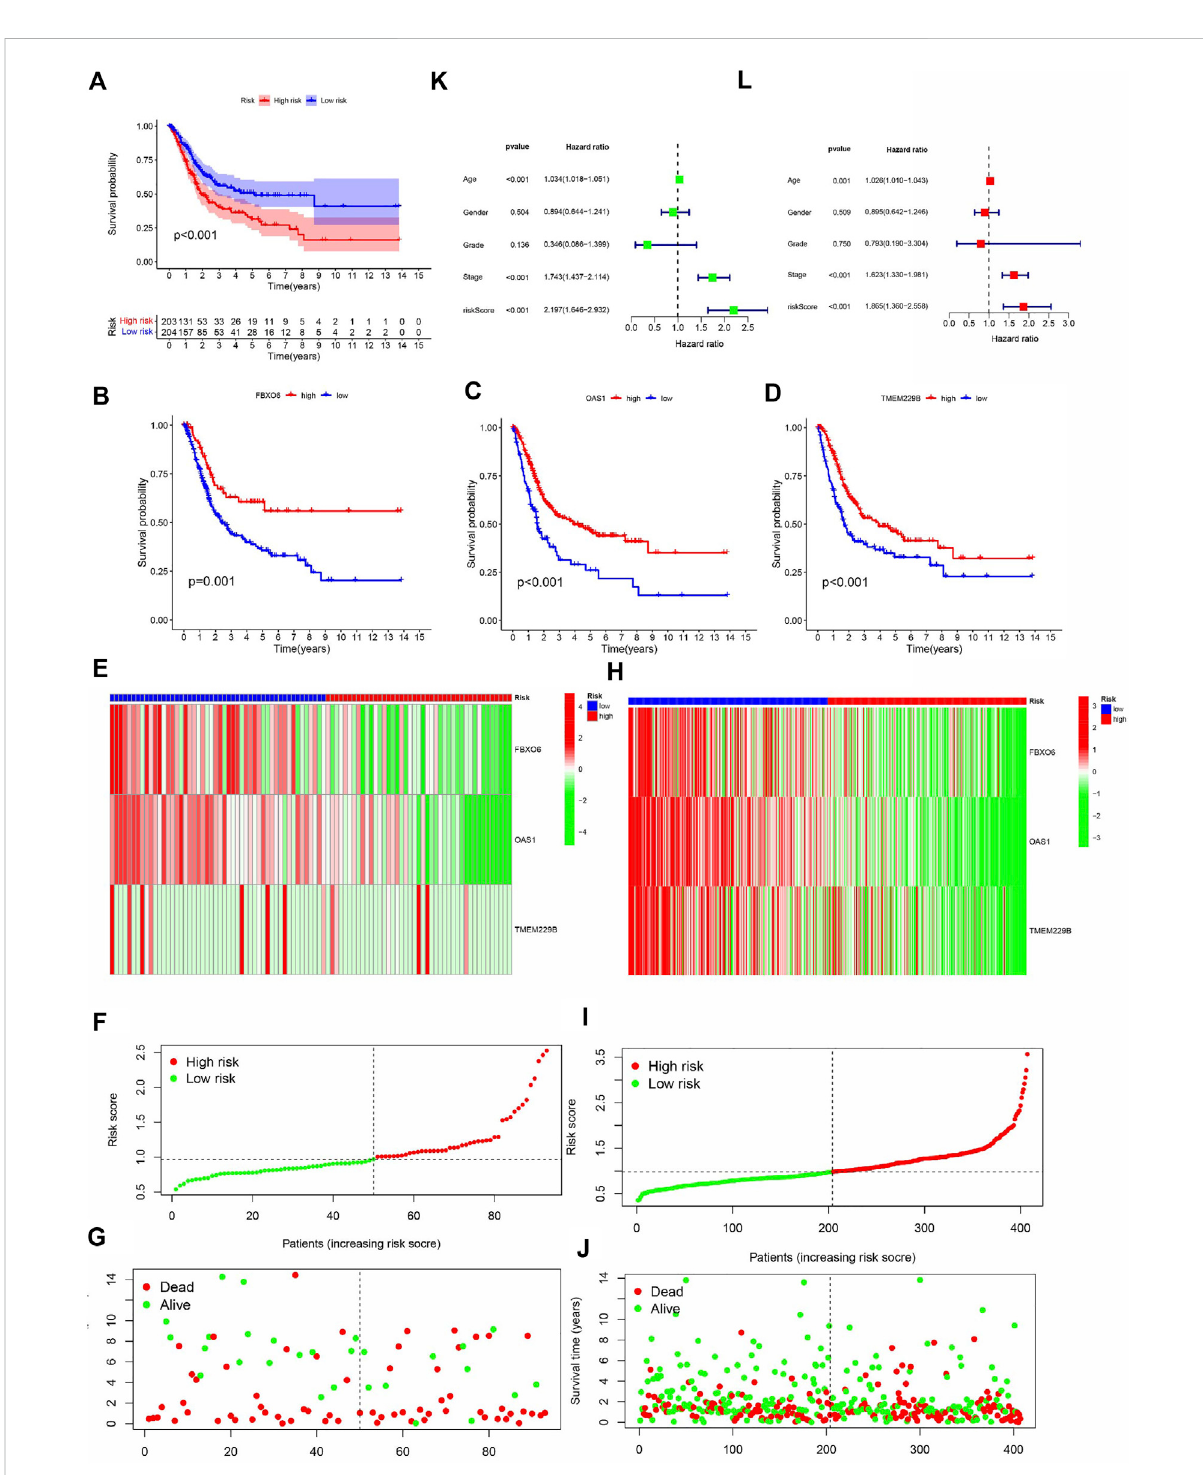
FIGURE 4 (A) TheanalysisofKaplan-Meiercurveshowsthatthereisadifferenceintheoverallsurvivalratebetweenhigh-riskandlow-riskgroups.Kaplan- MeiercurveanalysisshowedthatthereweredifferencesintheoverallsurvivalratesofFBXO6 (B) ,OAS1 (C) ,andtem229b (D) inhigh/low-riskgroups. IntheGEO (E) andTCGA (H) cohorts,heatmapsofFBXO6,OAS1,andTME229generatiosweredrawnforeachBLCAsample.IntheGEOcohort (F) as well as in the TCGA cohort (I) , the distribution of multi-genes model risk score. In the GEO cohort (G) as well as in the TCGA cohort (J) , the survival status and duration of BLAC